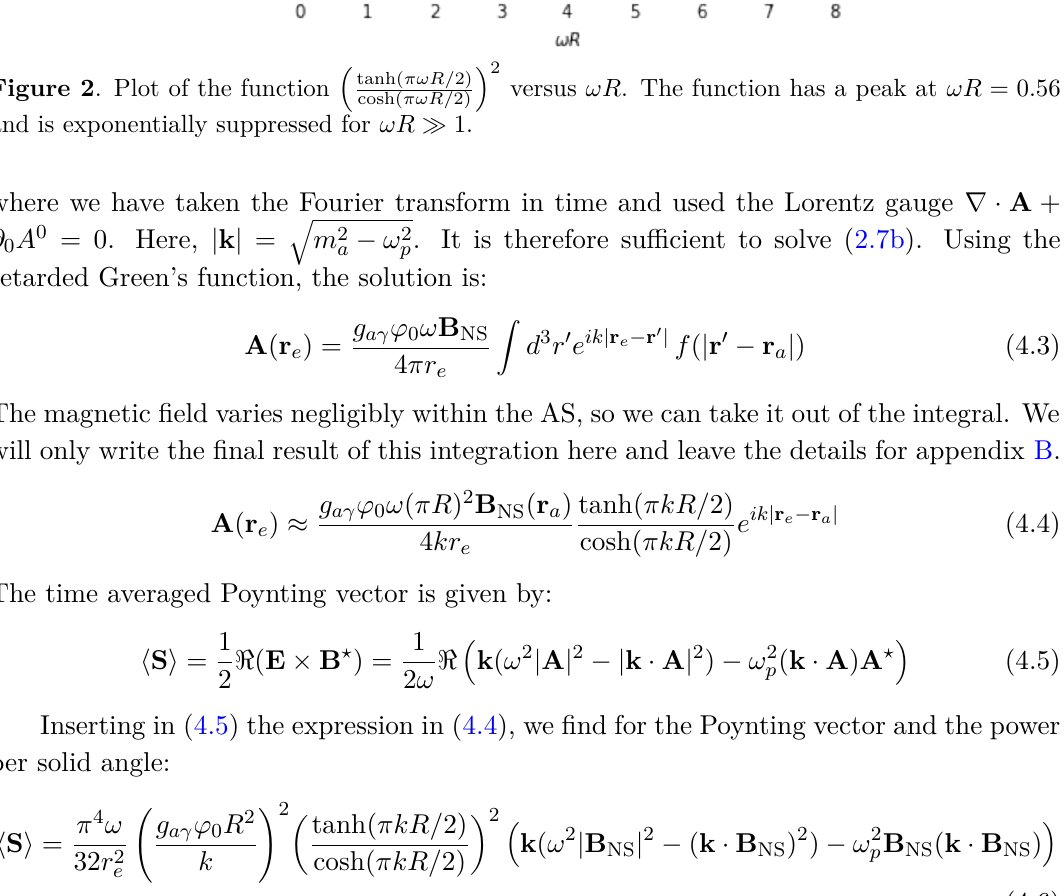
(cid:16) (cid:17) 2 tanh( πωR/ 2) versus ωR . The function has a peak at ωR = 0 . 56 cosh( πωR/ 2)